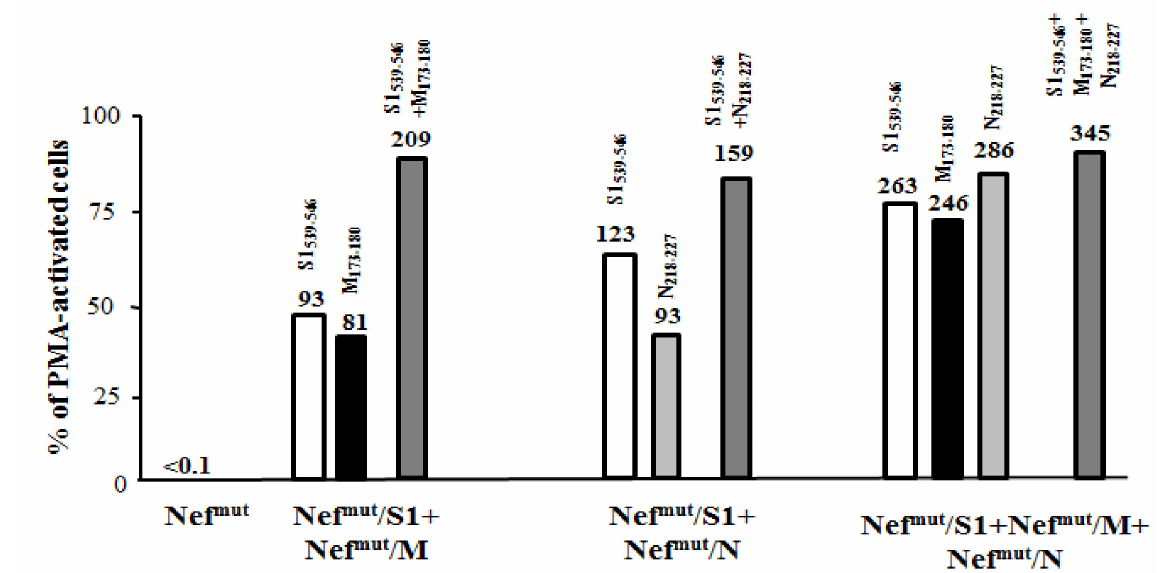
Figure 7. SARS-CoV-2-specific CD8 + T cell immune responses in cells from BALFs of mice immunized by combination of Nef mut -based DNA vectors. Shown are the percentages of SFUs detected in IFN- γ EliSpot microwells seeded with 10 5 cells from BALFs pooled from mice injected with the indicated combinations of DNA vectors in the presence of virus- specific peptides over SFUs scored in PMA plus ionomycin treated cells. Conditions comprising either single peptides or combinations thereof were tested. Samples tested in the presence of unrelated peptides scored at background levels. Absolute SFU numbers are also indicated. The results are representative of two independent